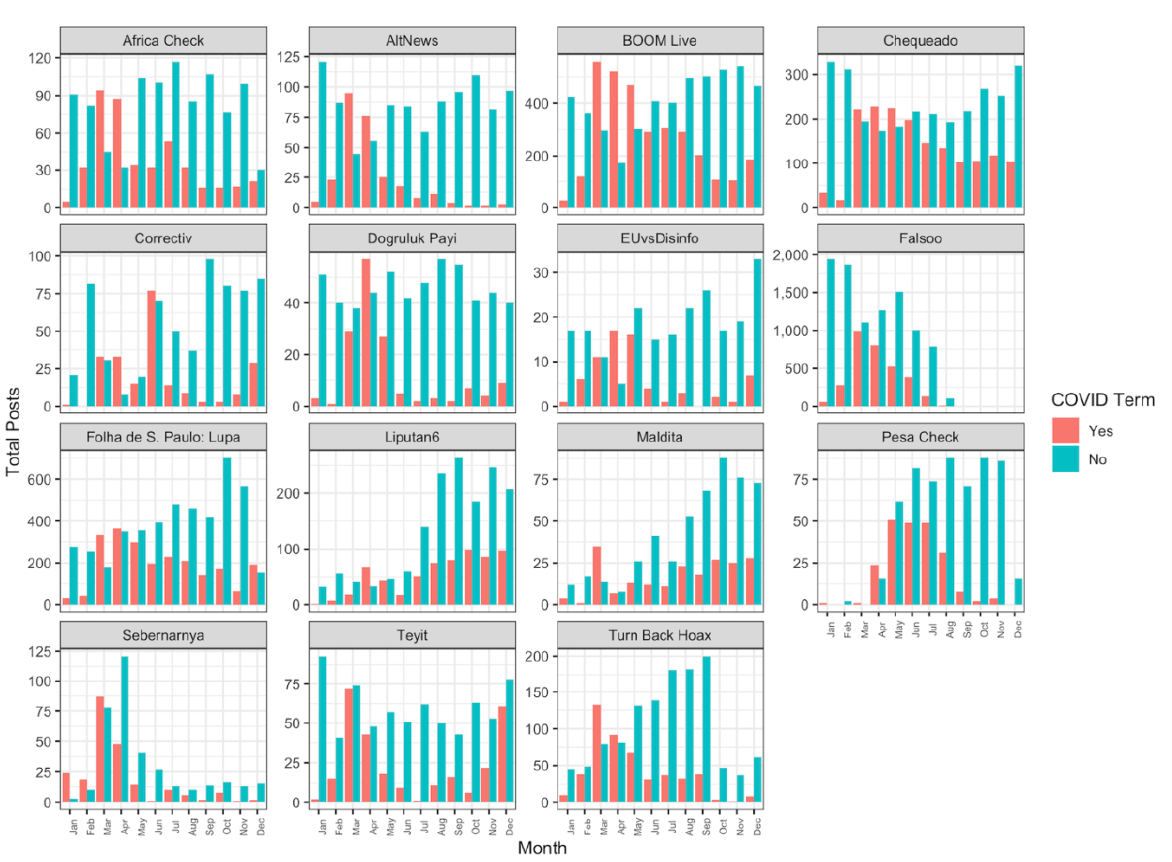
Figure 2. Distribution of COVID-related and unrelated tweets by fact checkers . The total posts by fact checkers for COVID content includes posts that included a URL to a fact-checking website and at least one of the keywords related to COVID. Posts with non-COVID content included posts that included a URL to a fact-checking website, but no keywords related to